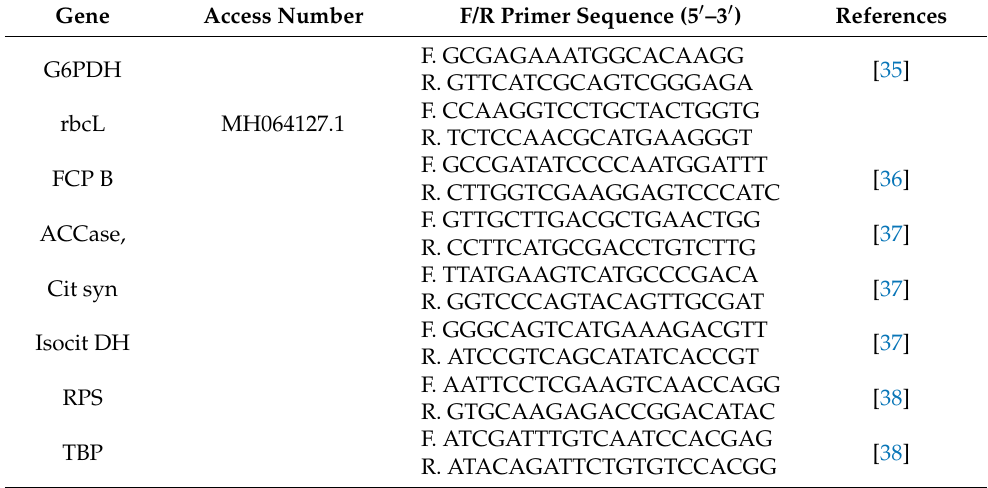
Table 1. Phaeodactylum tricornutum primer sequences used for real-time PCR. Gene Access